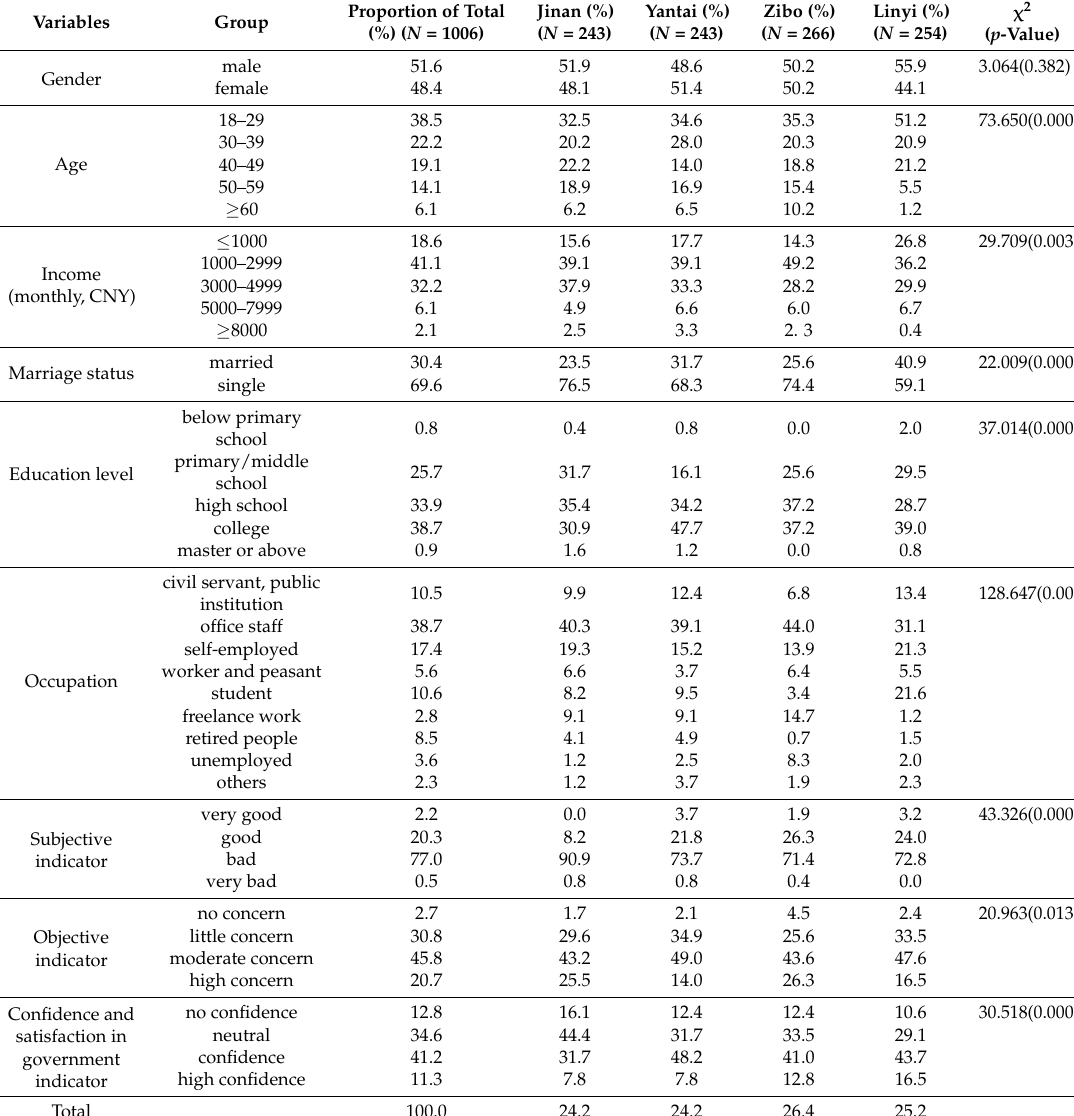
Table 4. Socio-economic characteristics and haze attitudes of the respondents ( N =